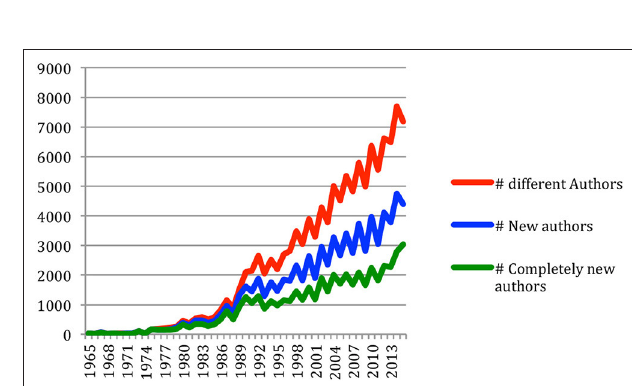
FIGURE 21 | Number of different authors, new authors and completely new authors over time.